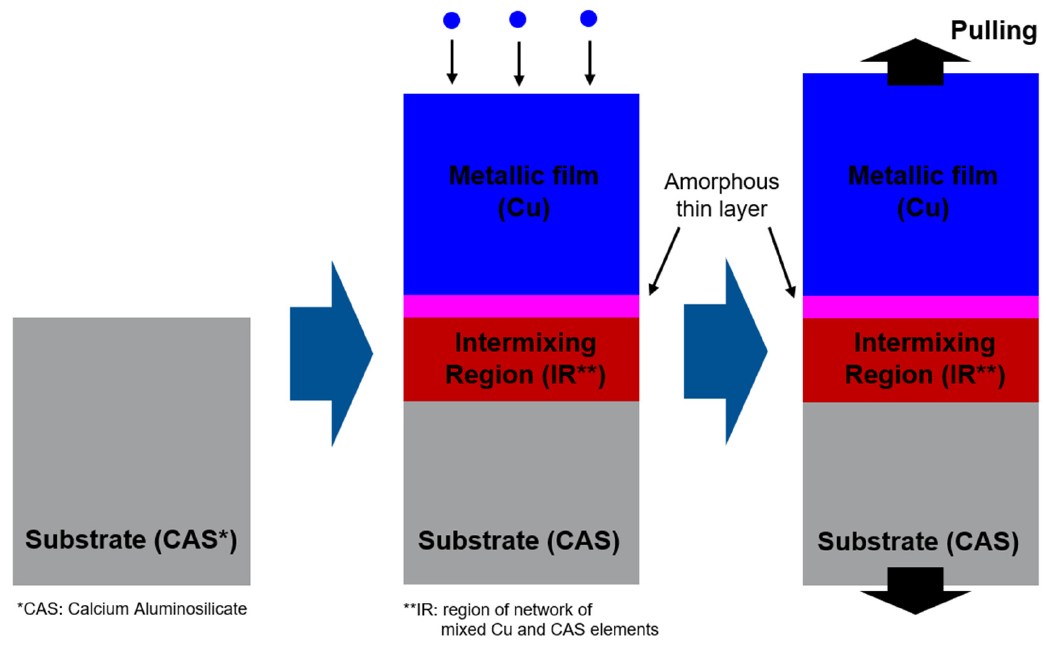
Figure 1. Scheme of modeling procedure for Cu sputter on glassy CAS and pulling process.